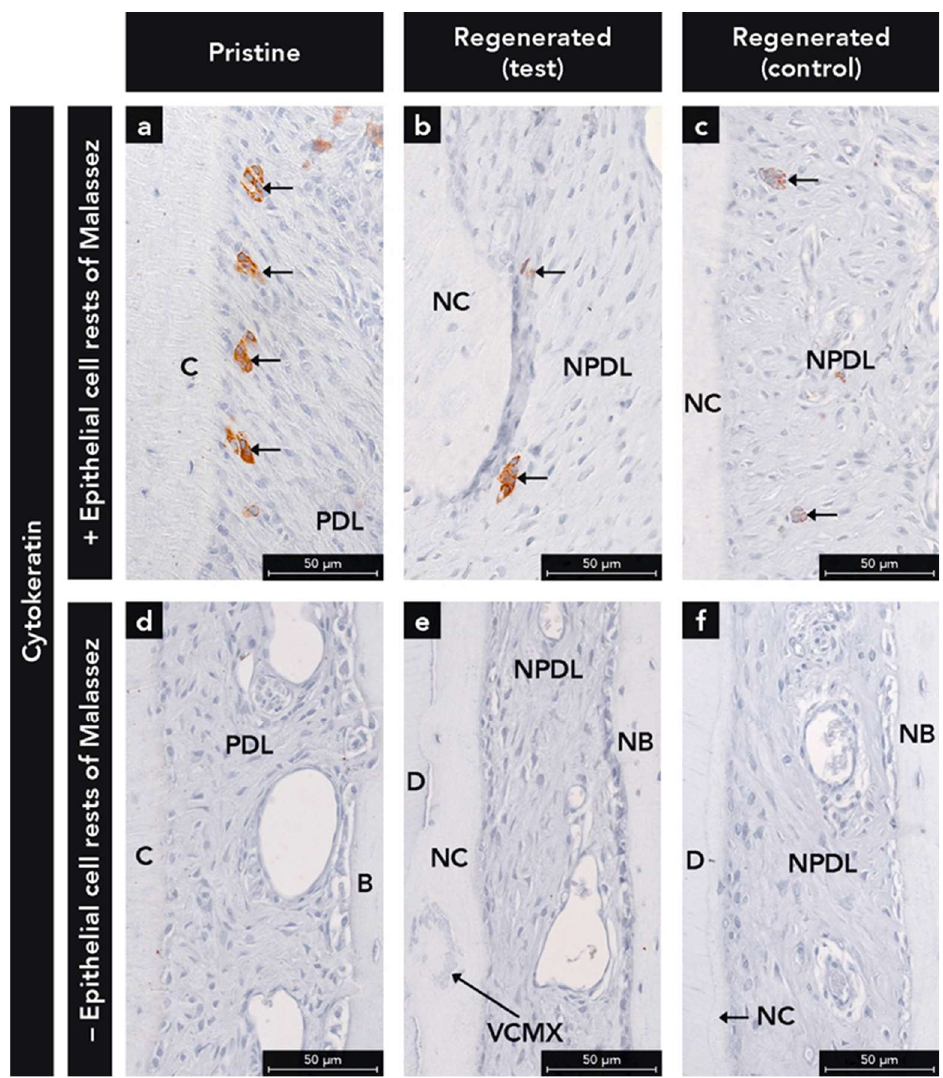
Figure 3. Micrographs demonstrating histological sections ( a – c ) with epithelial cell rests of Malassez (arrows) in periodontal ligament (PDL) and new periodontal ligament (NPDL) as demonstrated by immunostaining with the use of a pan-cytokeratin antibody and ( d – f ) without epithelial cell rests of Malassez; ( e ) Integration of the volume stable collagen matrix (VCMX) in new cementum (NC); Counterstaining: Mayer’s hematoxylin; C, cementum; D, dentin; NB, new bone.